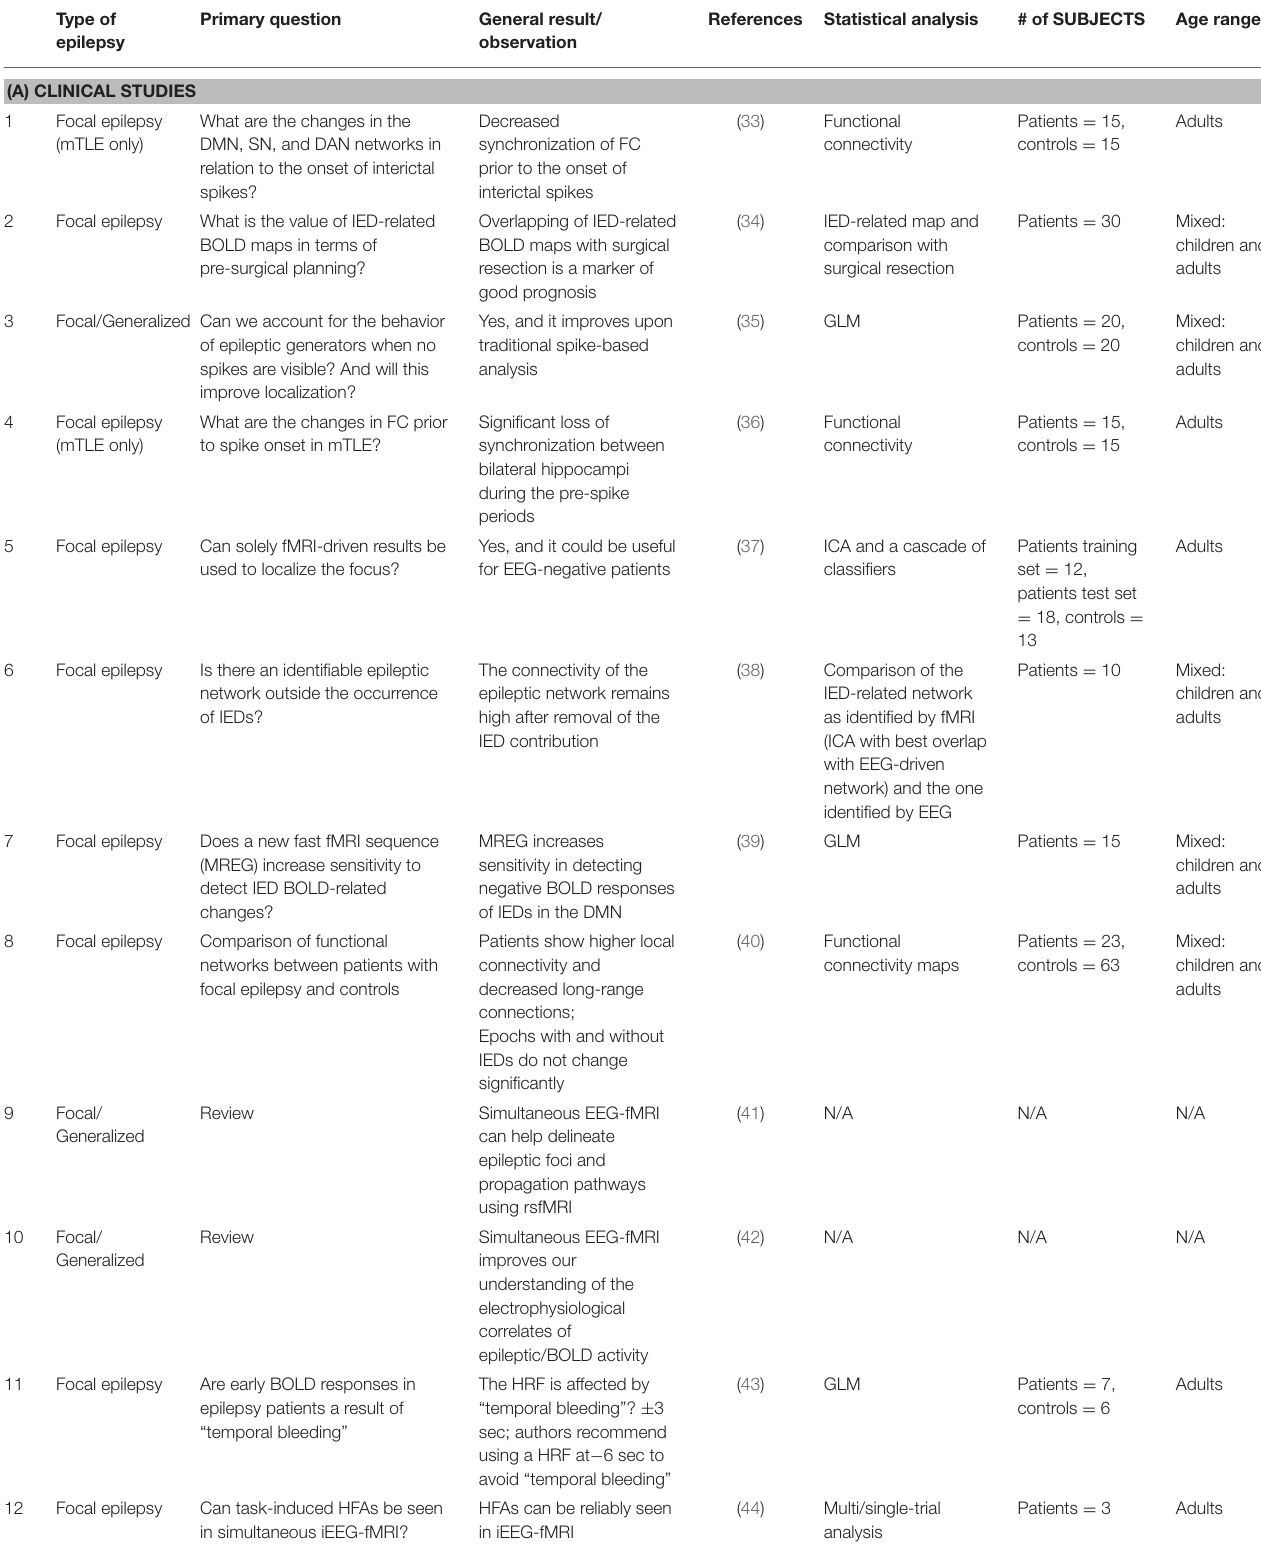
TABLE 1 | Epilepsy types